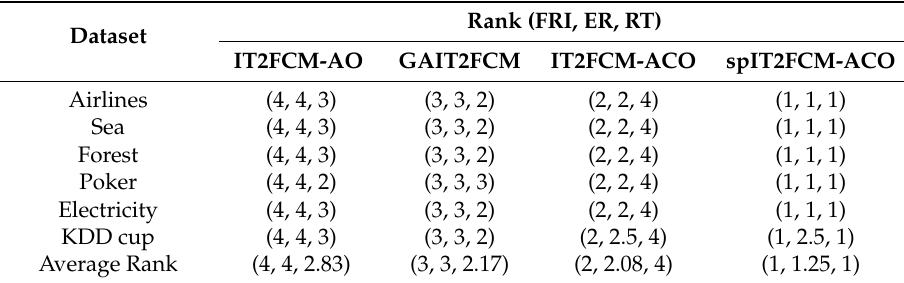
Table 9. Ranking of Algorithms based on FRI, ER, and